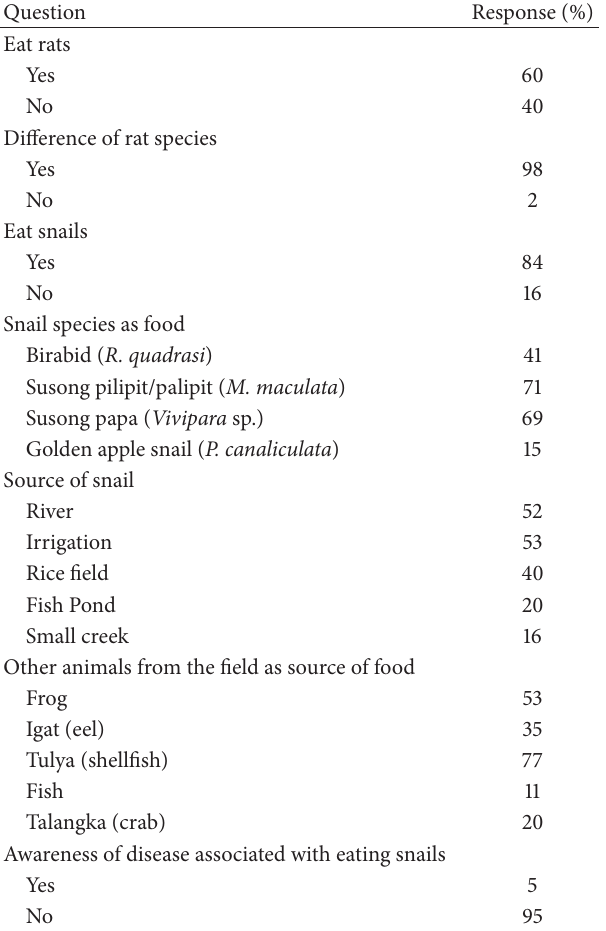
Table 4: Response of the local people in Mu˜noz, Nueva Ecija regarding awareness on parasitic diseases from rats and